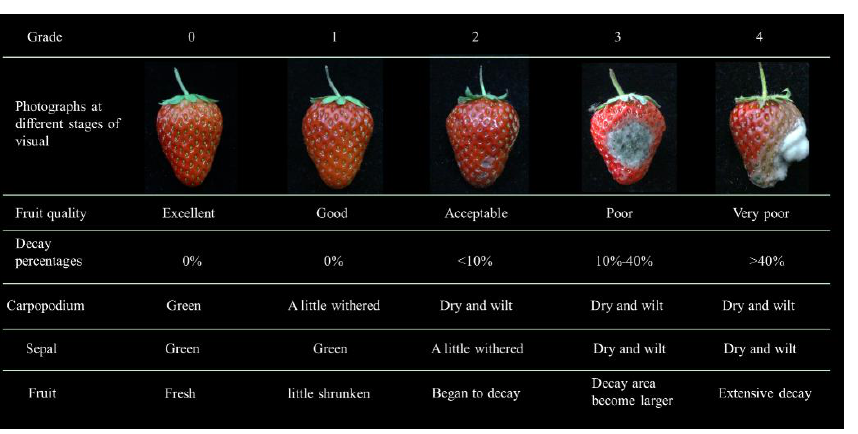
4 of 20 Figure 1. Experimental process flow chart. TSS, total soluble solids; TA, titratable acidity; TAC, total anthocyanin content; MDA, malondialdehyde; SOD, superoxide dismutase; CAT, catalase.